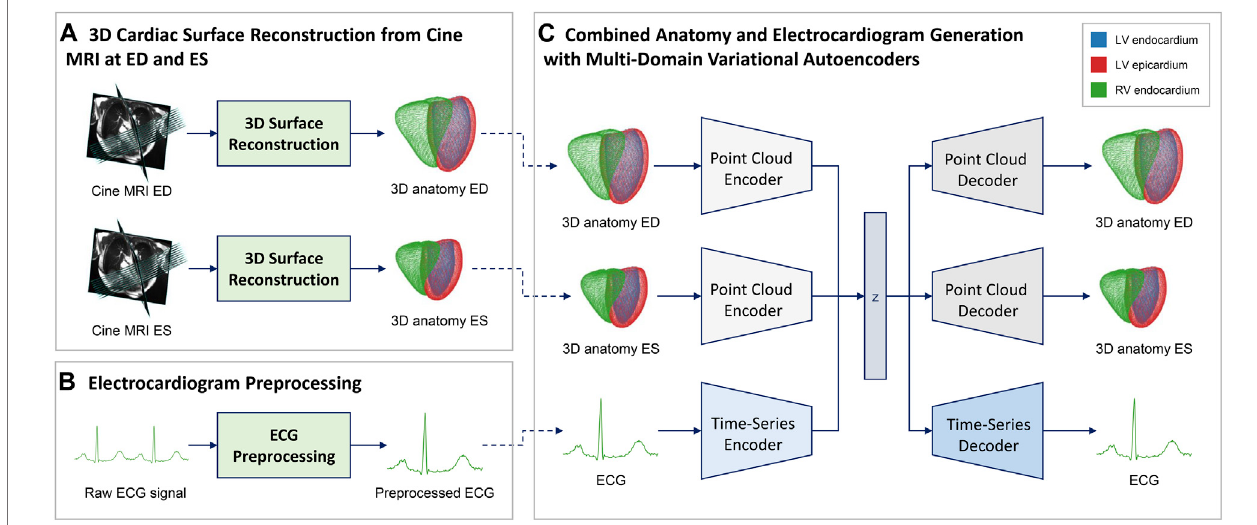
FIGURE 1 | Overview of the proposed combined anatomy and ECG modeling pipeline. We fi rst reconstruct point cloud representations of the 3D biventricular anatomy at theEDand ESphaseofthe cardiac cycle (A) and preprocess theraw ECG acquisitions (B) tocreate amulti-domain dataset. Wethen use thisdatato traina multi-domainvariationalautoencoder (C) tocapturecombinedcardiacanatomyandelectrophysiologyinformationinasinglemodel.TheVAEarchitecture (C) consistsof three separate encoder-decoder branches, one for each network input (ED anatomy, ES anatomy, ECG), that share a common latent space for cross-modal information exchange. Each branch architecture is speci fi cally tailored to the requirements of the respective input type, i.e. point clouds for anatomy and time series for ECG processing ( Figure 2 ).